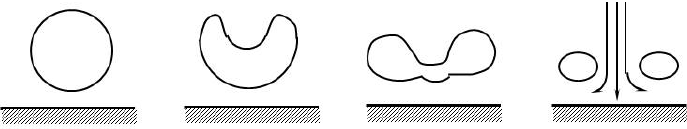
Figure 12. The collapse process of a single spherical bubble.